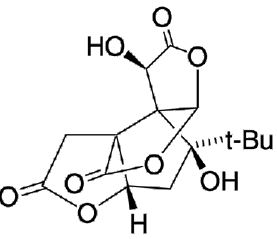
Figure 3. Chemical structure of bilobalide (adapted from [63]).